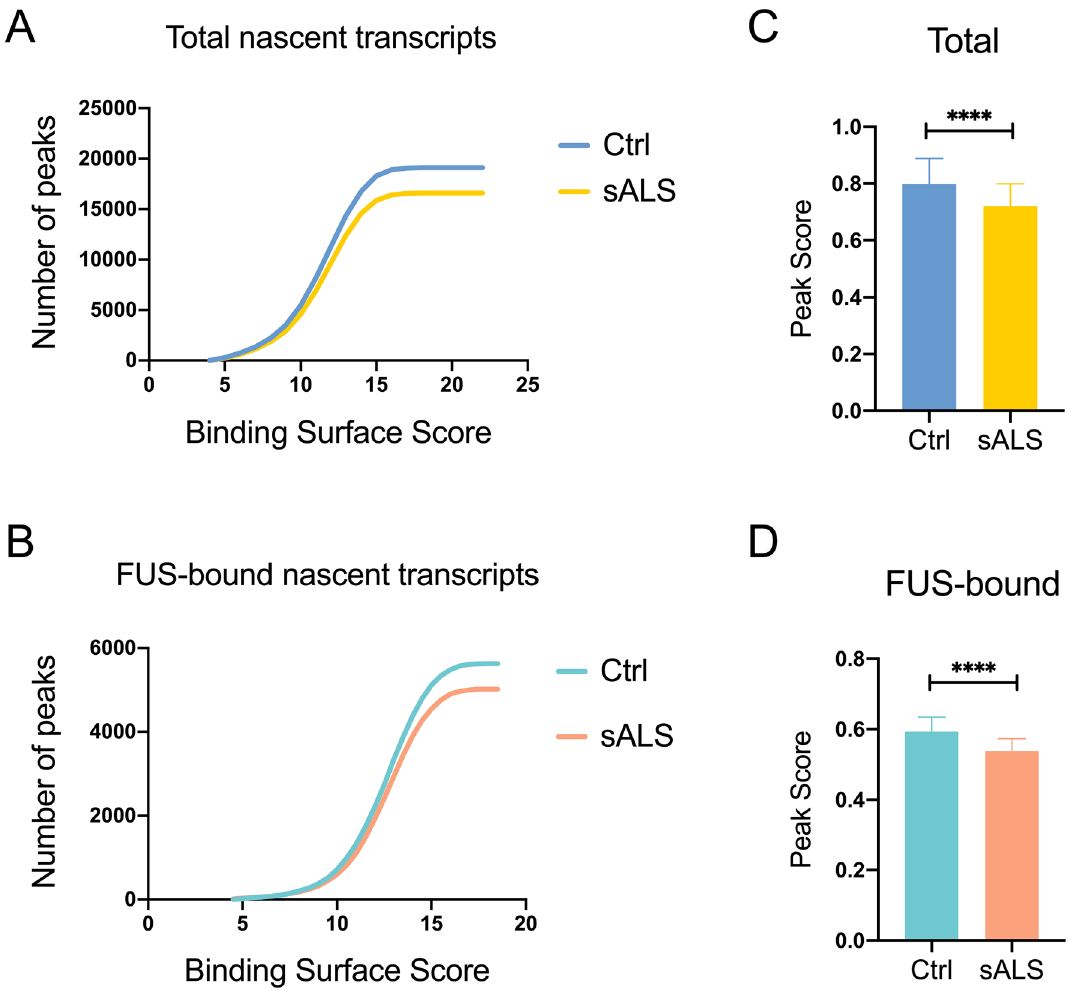
Figure 6. Nascent transcript levels are reduced in iPS cells derived from sporadic ALS patients Cumulative nascent transcript peak distribution of binding surface score of (A) total and ( B ) FUS-bound nascent transcripts in control (Ctrl) and sporadic ALS (sALS) iPSCs. (**** p < 0.0001) Mann–Whitney U -test. ( C , D ) Mean expression level of ( C ) total and ( D ) FUS-bound nascent transcripts in control and sporadic ALS iPSCs. (**** p < 0.0001) Mann–Whitney U